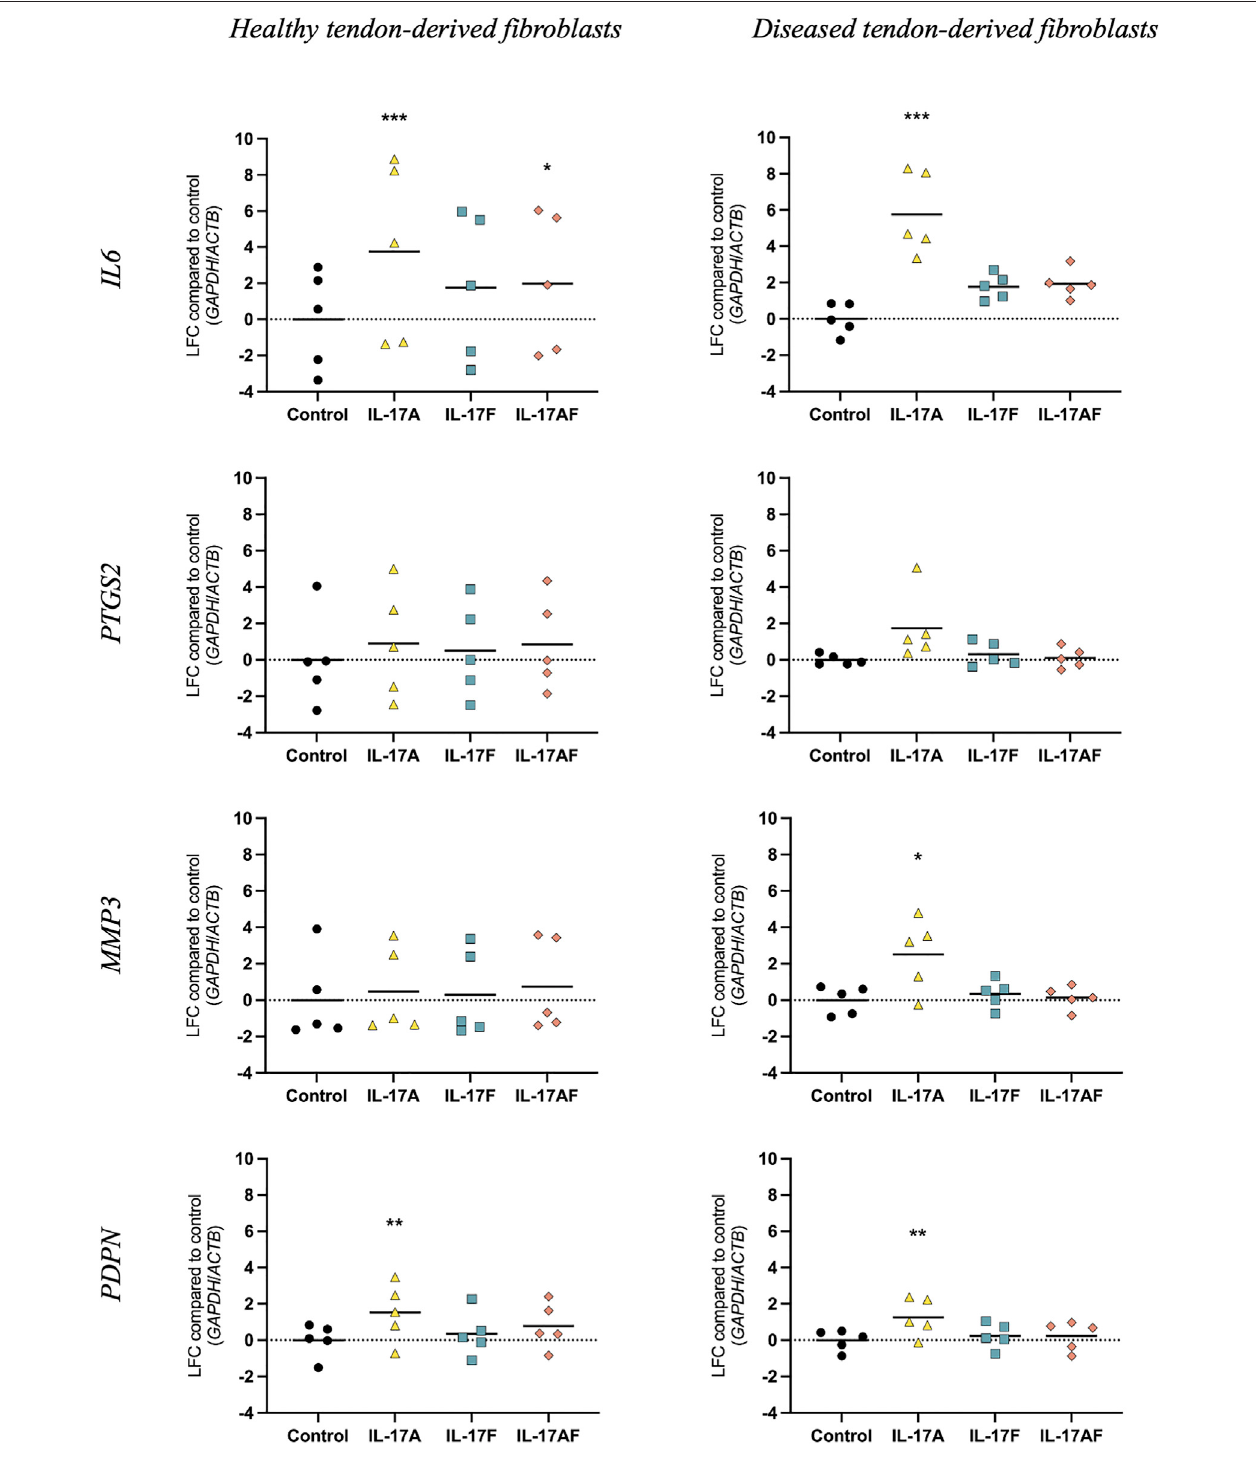
FIGURE3| ChangesinmRNAexpressionaftertreatmentwithIL-17A,IL-17F,orIL-17AFcomparedtovehiclecontrolin fi broblastsderivedfromhealthyhamstring or diseased supraspinatus tendons with a large or massive tears. mRNA expression was calculated using the ddCT-method using the reference genes GAPDH and ACTB , and is expressed as log2 fold change (LFC) compared to control. Changes in mRNA expression compared to control were calculated using a Friedman test with Dunn ’ s multiple comparisons test. Individual values and mean. N (cid:1) 5. * (cid:1) p < 0.05, ** (cid:1) p < 0.01, *** (cid:1) p < 0.001.